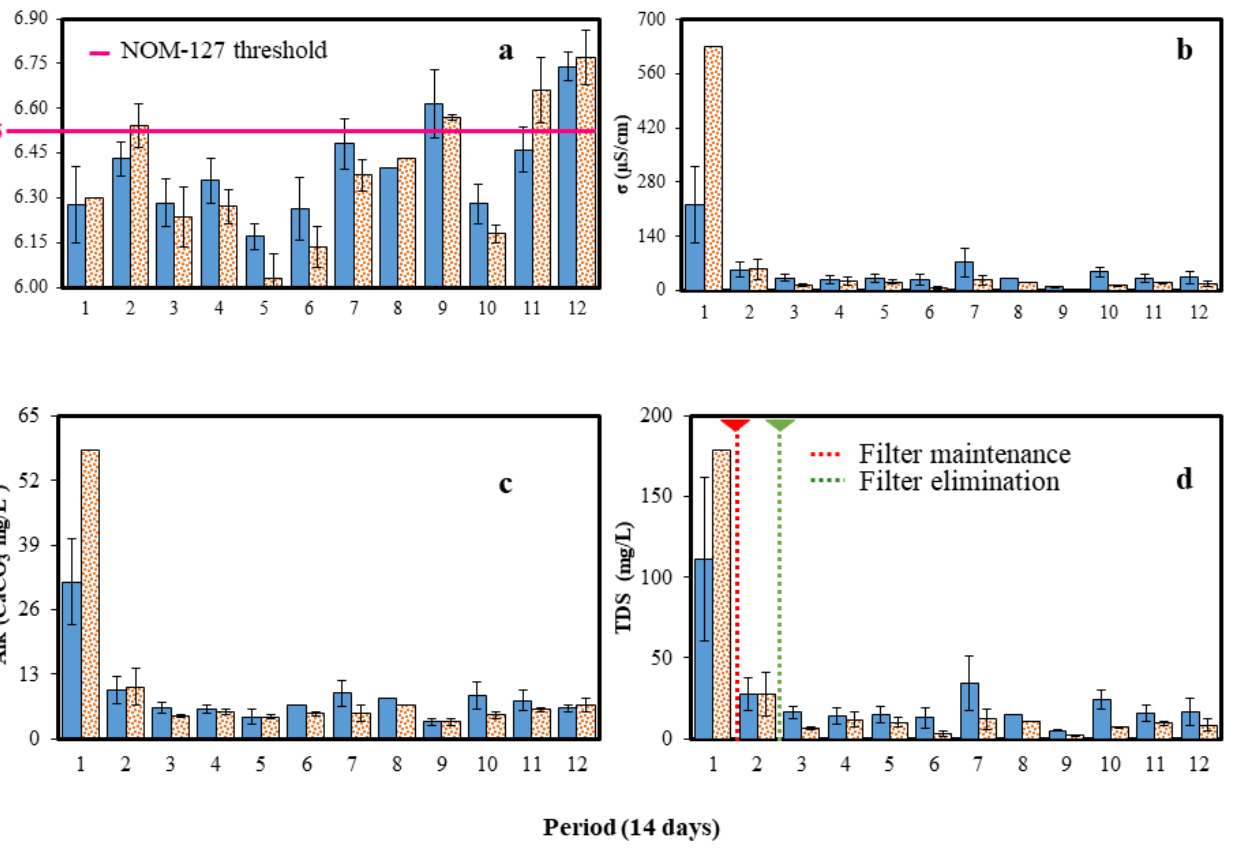
Figure 7. Physicochemical parameters of rainwater collected in 2021. ( a ) pH, ( b ) electrical conductivity (σ), ( c ) alkalinity (Alk), and ( d ) total dissolved solids (TDS). NOM-127 = NOM-127-SSA1-2021. Data are presented as the average and the bars represent the standard error, where n = depends on the number of rainfall events recorded per period, except in periods 1 and 8 where n = 1 because only one sample was collected from the ST, whereas in period 8 only one sample was collected from FRS and ST. Blue bars represent FRS values and orange hatched bars represent ST values.